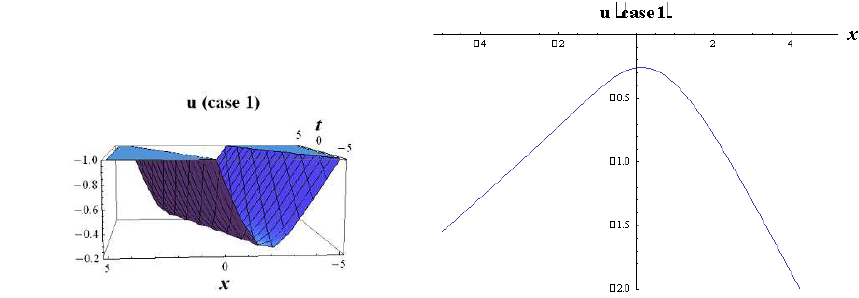
Fig. 1 The 3D and 2D surfaces of the solution for (16) for suitable values